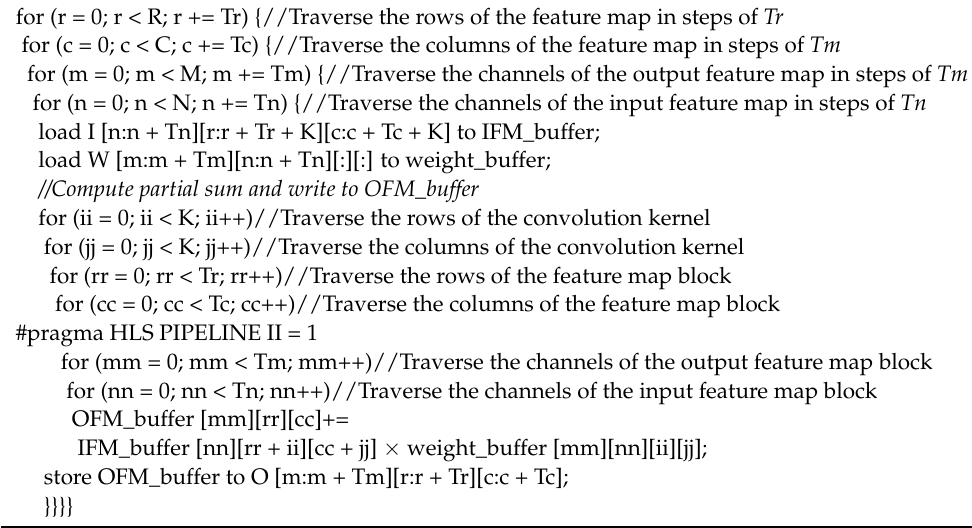
Algorithm 1 Pseudo code of optimized convolutional